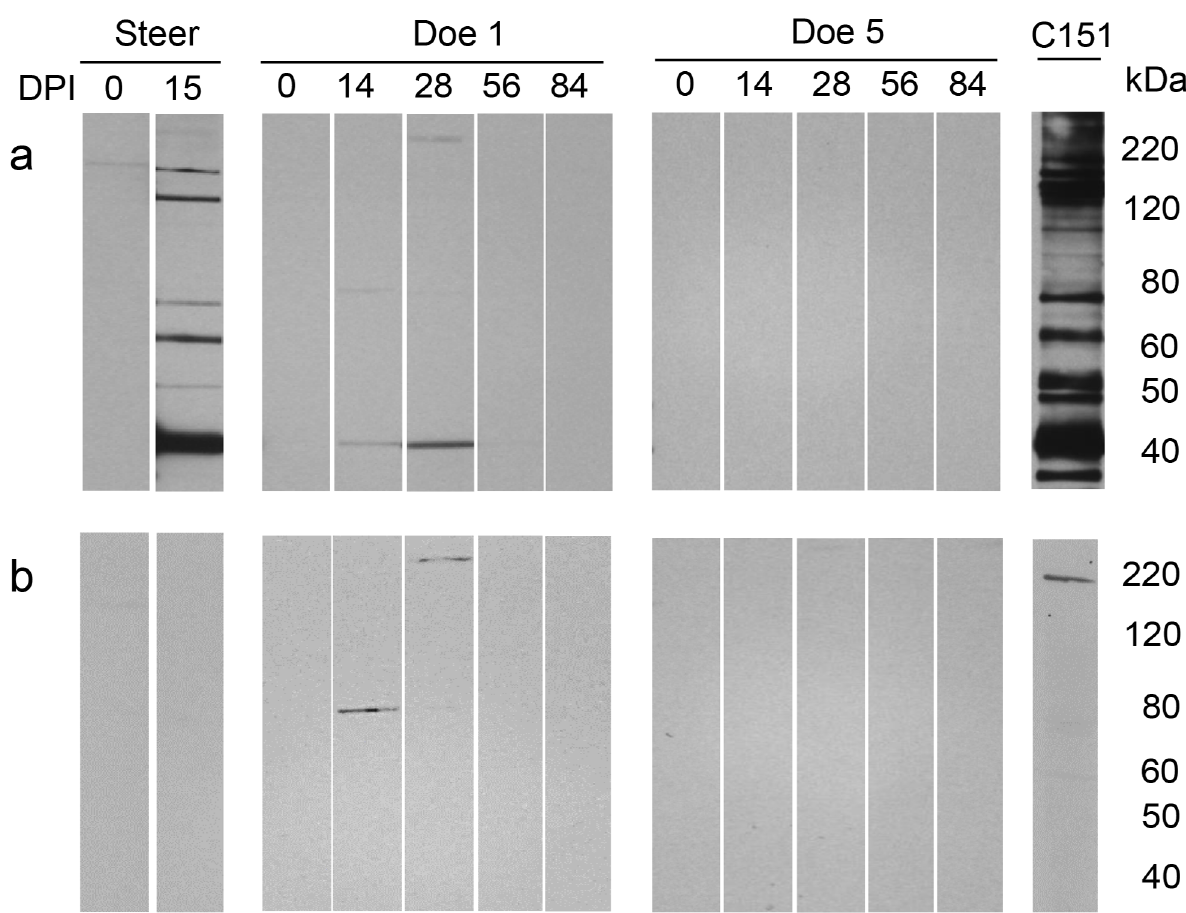
Fig 2. Detection of serum antibody reactivity to B . bovis infected erythrocyte and normal erythrocyte antigens after inoculation with a blood stabilate. Serum antibody from representative deer challenged with either B . bovis blood stabilate (Doe 1) or a larval extract containing B . bovis sporozoites (Doe 5) was evaluated by immunoblot. a) B . bovis infected erythrocyte antigen and b) normal bovine erythrocyte antigen. Steer: challenged with B . bovis blood stabilate and C151: bovine persistently infected with B . bovis . DPI: days